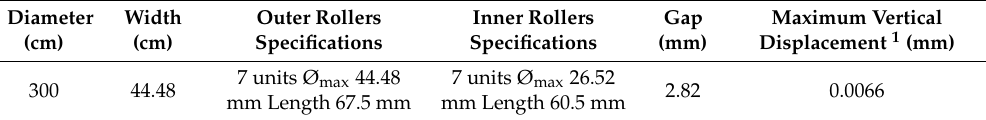
Figure 6. CAD section showing the alternate use of the two passive roller types and the gap between them. Table 2. Main mechanical features of the omnidirectional wheels. Table 2. Main mechanical features of the omnidirectional